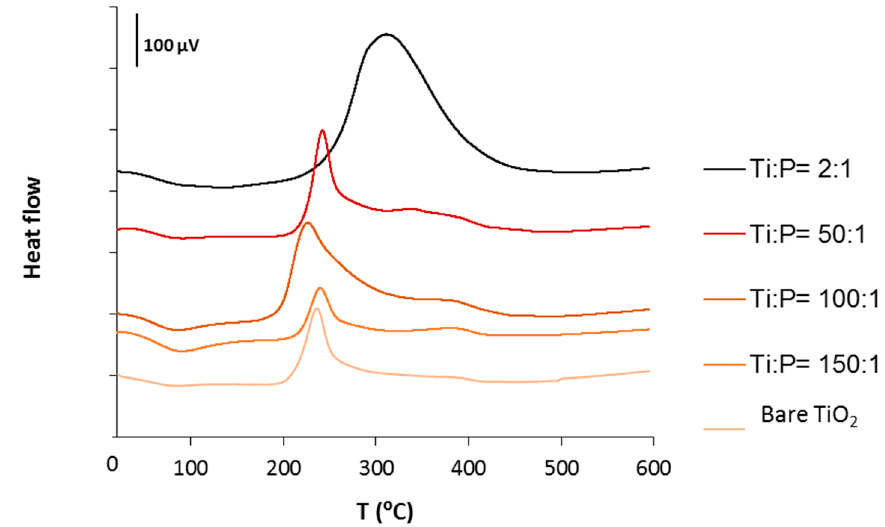
Figure 3. TDA of bare and some hybrid TiO 2 samples (samples Ti/P= 25; 75, 125 and 200 are omitted for clarity).